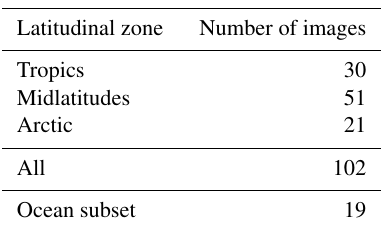
Table 1. The number of images in the Hyperion sample set (102 images) collected in each latitudinal zone. The ocean category also includes images taken in the regions of tropics, midlatitudes, and Arctic.